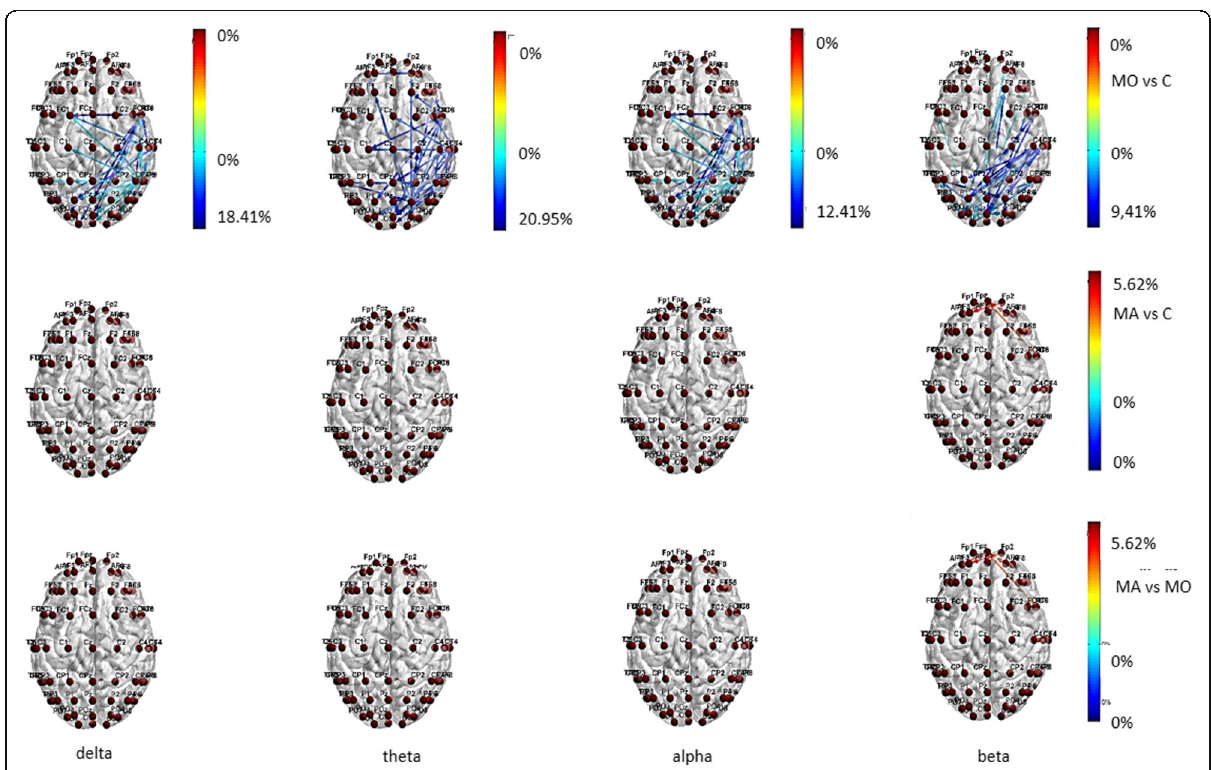
Fig. 1 Statistical differences in information transfer and their relative directions among nodes in resting state EEG bands are depicted in the Migraine with aura (MA), Migraine without aura (MO) and Controls (C) groups . Hot colors refer to a statistical prevalence of information transfer in the first element of the comparison, and cold colors for the vice-versa. The color intensity is graduated on the relative percent